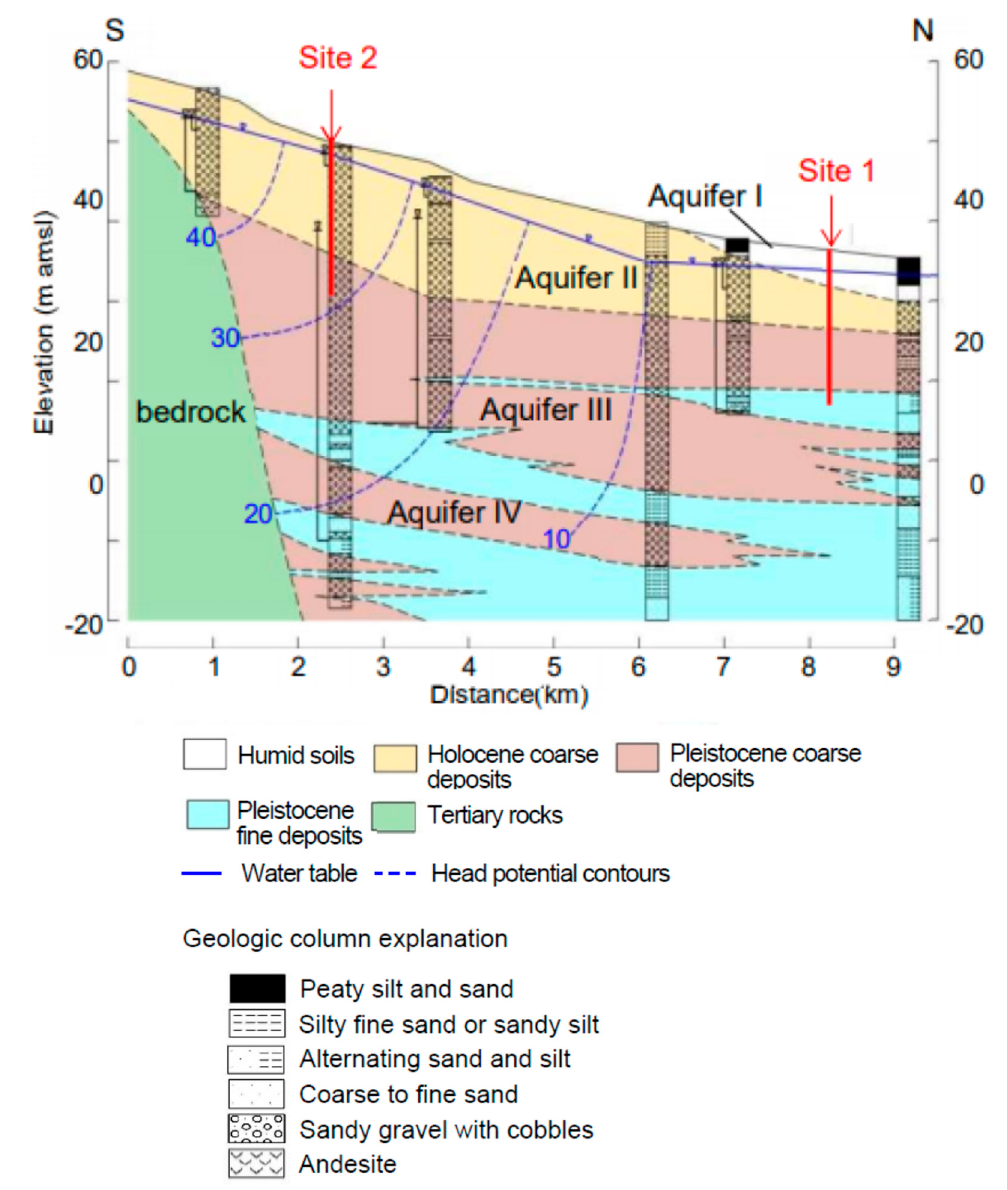
Figure 3. Hydrogeologic cross section along the S–N direction along the black line in Figure 2, modified from [15]. Figures 2 and 3 also show two experiment sites: Site 1 near the fan toe (43.067 ◦ N and 141.320 ◦ E), and Site 2 in the fan apex (43.030 ◦ N and 141.383 ◦ E), respectively. At Site